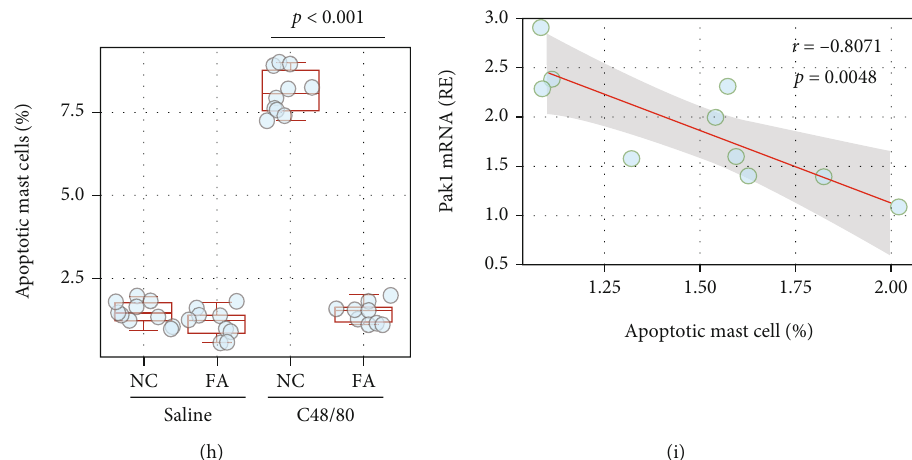
Figure 1: Pak1 is correlated with mast cell apoptosis resistance. (a – c) Mast cells were isolated from the mouse intestine and analyzed using RT-qPCR and Western blotting: (a) Pak1 mRNA levels; (b) Pak1 protein levels; (c) integrated density of Pak1 blots in (b). (d) Mast cell frequency in LPMCs (lamina propria mononuclear cells). (e) Positive correlation between Pak1 mRNA levels in mast cells and mast cell frequency in LPMCs. (g, h) Mast cells were isolated from LPMCs and exposed to C48/80 in the culture overnight. Gated FCM plots show apoptotic mast cell counts. Boxplots show summarized apoptotic mast cell counts. (i) Negative correlation between Pak1 mRNA levels in mast cells and the apoptotic mast cell counts. Each bubble in boxplots presents data obtained from one sample. The data of (b) are from one experiment that represents 3 independent experiments with pooled protein extracts from mast cells obtained from 10 experiments. NC: naïve control